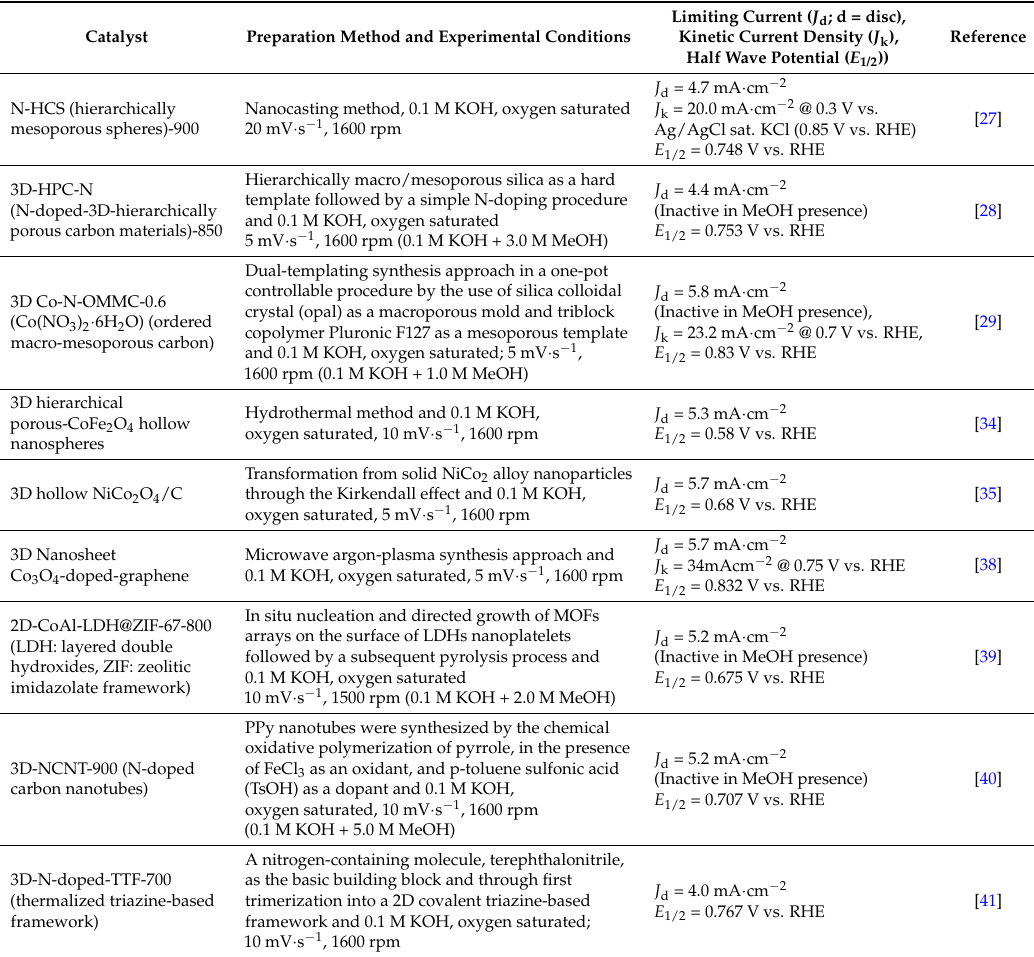
Limiting Current ( J d ; d = disc), Kinetic Current Density ( J k ), Reference Half Wave Potential ( E 1/2 ))